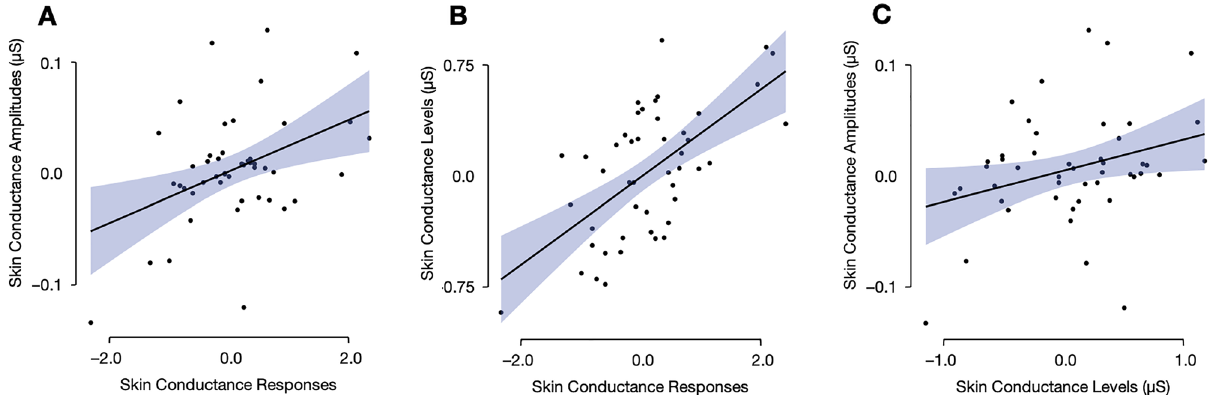
Figure 3. Correlation plots depicting the relationship between the skin conductance measures: SCA and SCR ( A ), SCL and SCR ( B ), as well as SCA and SCL ( C